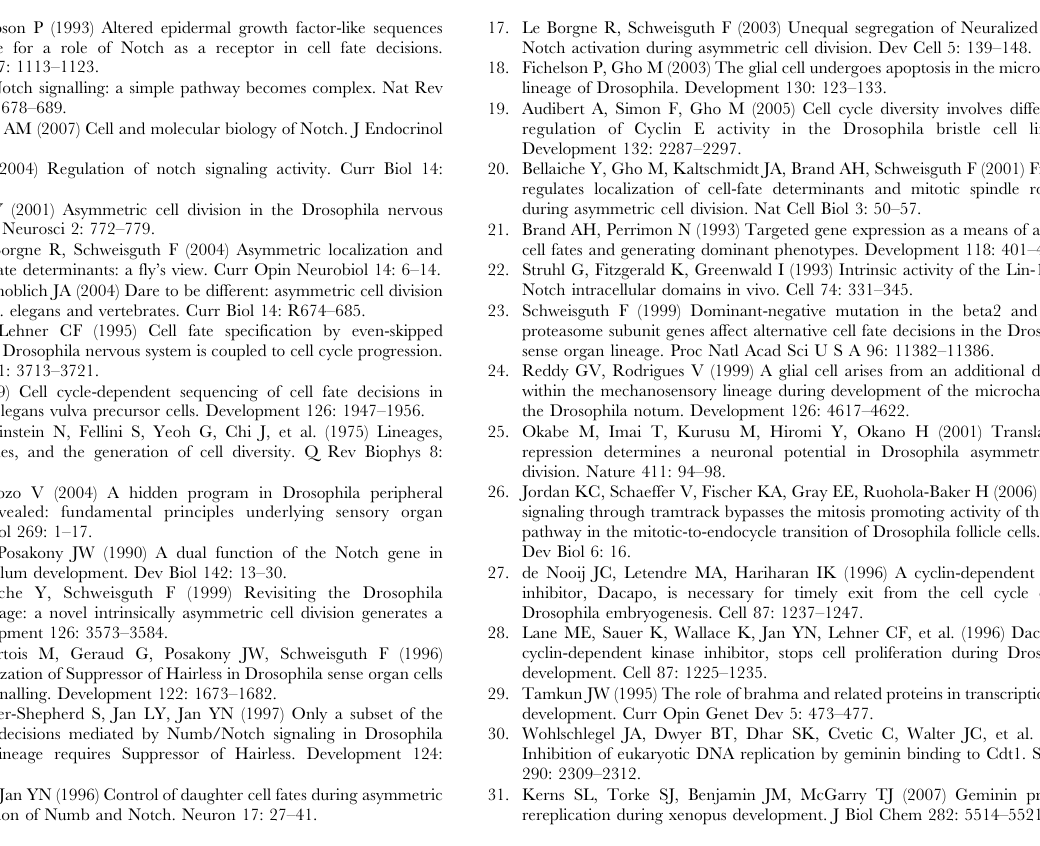
of life induces an ectopic expression of Tramtrack in the anterior cell. The expression of Ttk was used as an index of the Notch pathway activation in the anterior secondary precursor cell.